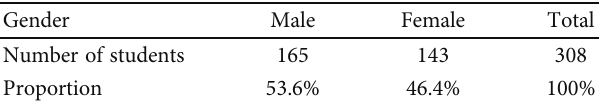
Table 1: Gender composition of surveyed students.